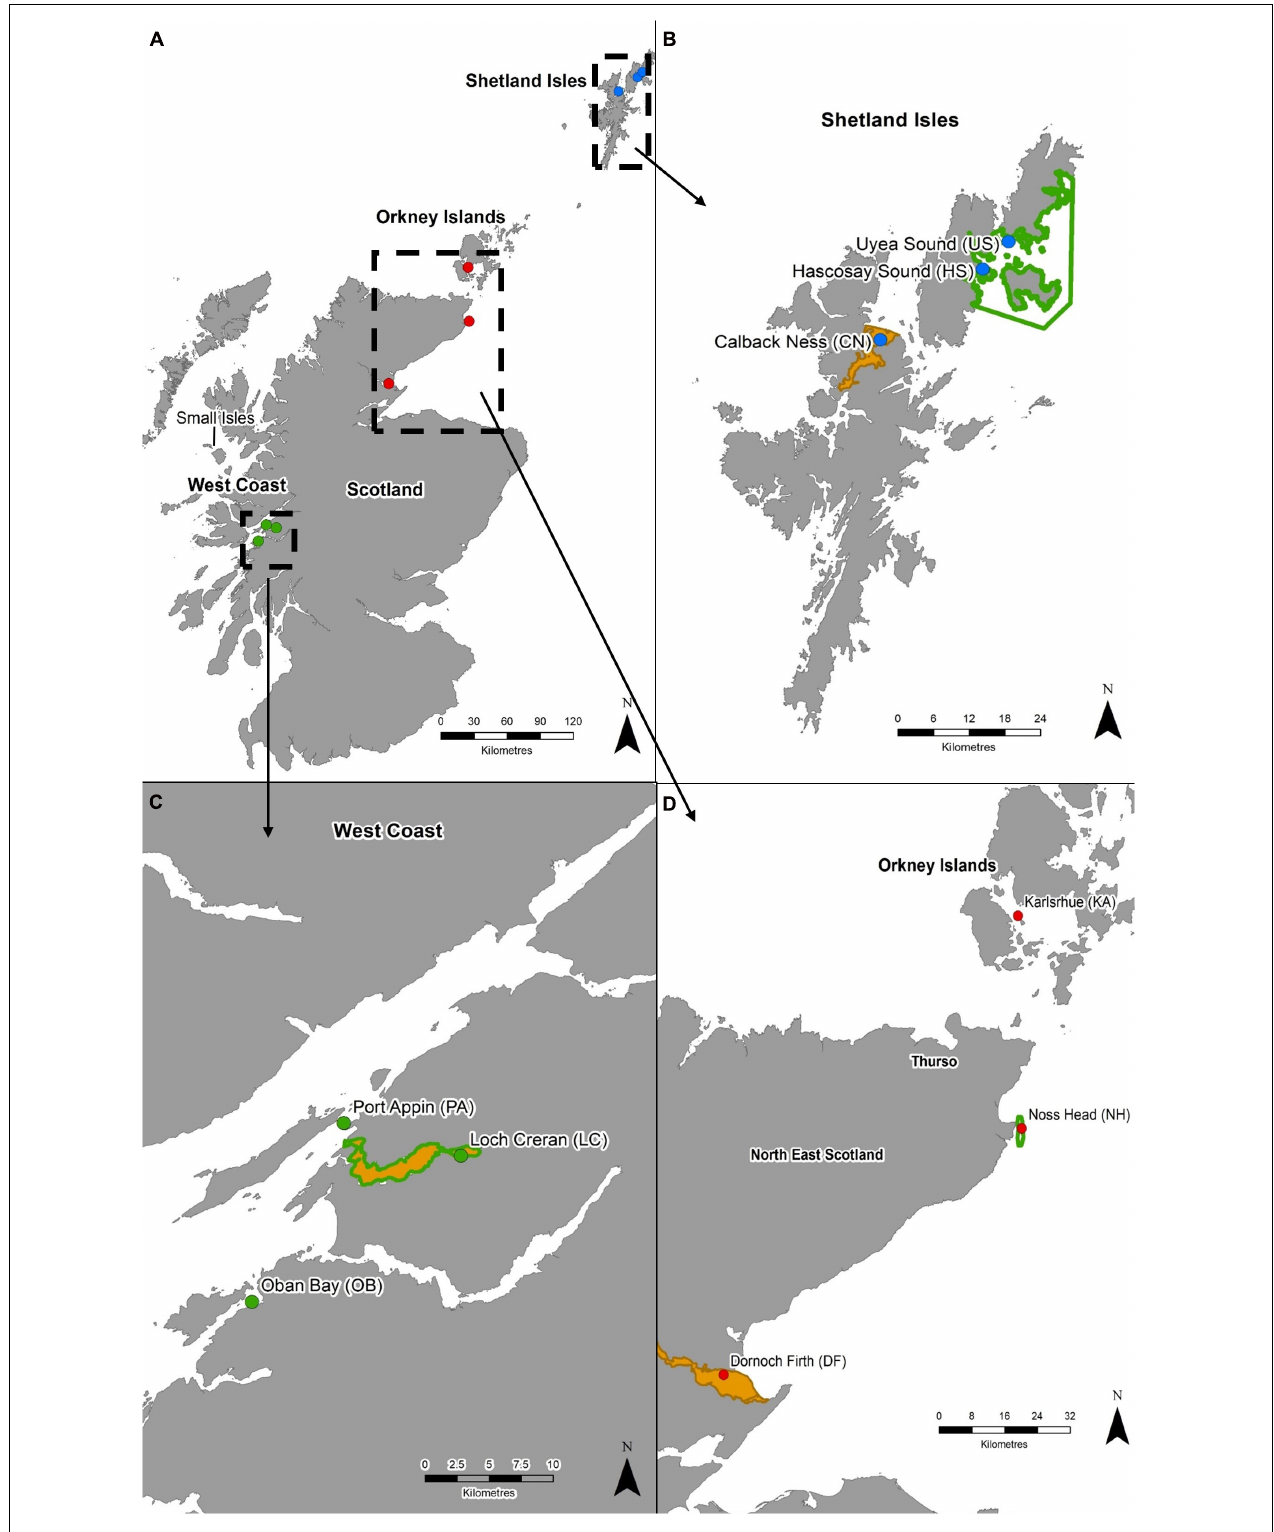
FIGURE 1 | (A) Modiolus modiolus reef populations of Scotland included in genetic analyses. Dashed boxes indicate sampling regions: (B) Shetland Isles, (C) West Coast, and (D) North-east and Orkney Islands. Protected areas are shown as solid orange polygons (SACs) and green polygons (NC MPAs). Coastline Crown © and database right (2021). Ordnance Survey License number